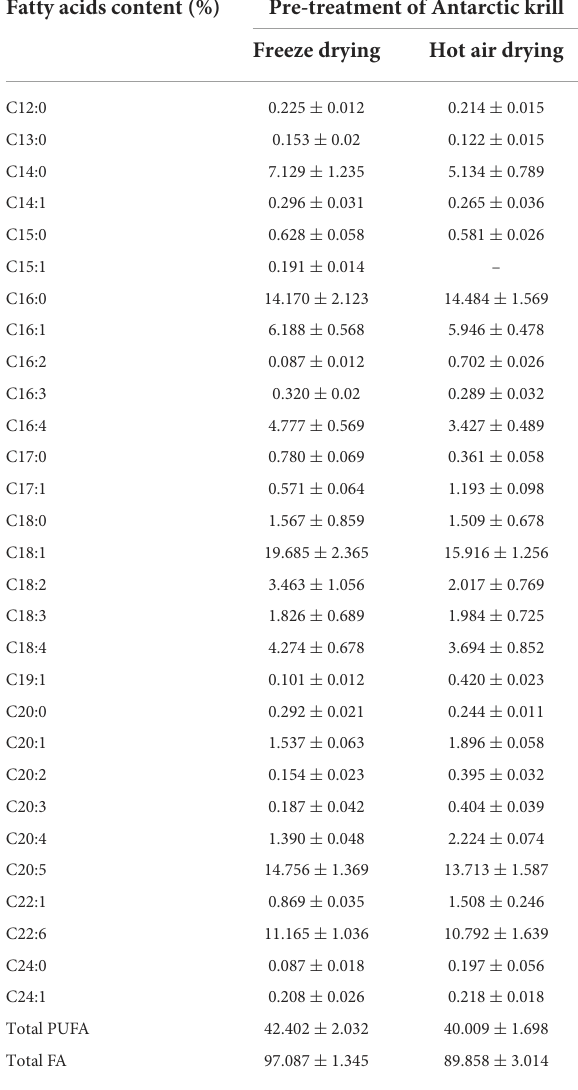
TABLE 1 Characterization of SFE-extracted fatty acids using GC-MS. Fatty acids content